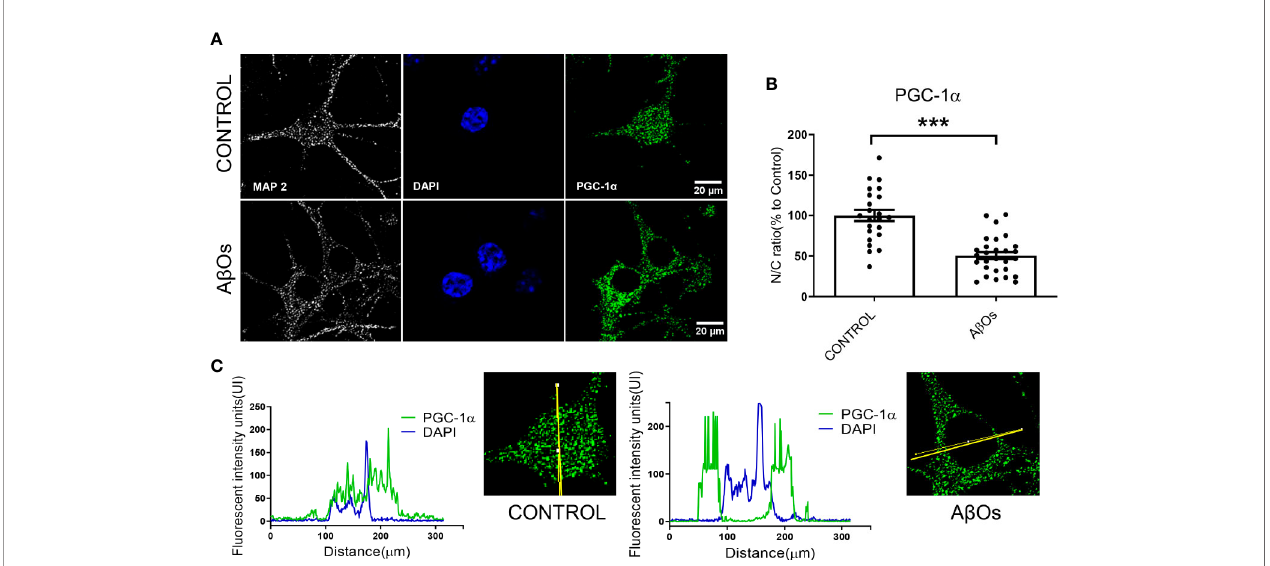
FIGURE 8 | Immunocytochemistry to evaluate the PGC-1 a distribution in hippocampal neurons treated with A b Os. (A) Representative confocal images of immunoreactivity for speci fi c primary antibodies for PGC-1 a (Green) and DAPI (blue) in PC-12 cells in control condition (upper panel) and after 24 h of A b Os treatment (0.5 µM, lower panel). (B) Quanti fi cation of the nucleus/cytosol (N/C) ratio for images shown in A. (C) Plot pro fi les for images showing the intensity of fl uorescence in control condition (left panel) and after 24 h treatment with A b Os (right panel) of images obtained in A. Scale bars: 20 m m. Data are represented as mean ± SEM. ***p < 0.001 compared between the control group. One-way ANOVA with the Dunnett's multiple comparisons test was used for all statistical analyses. PGC-1 a , Peroxisome proliferator-activated receptor gamma coactivator 1-alpha; SIRT1, silent information regulator 2 homolog 1. (n=3, N=23 – 28) (hinmunocytochemistry with controls ares provided in Supplementary Figure 8 ).